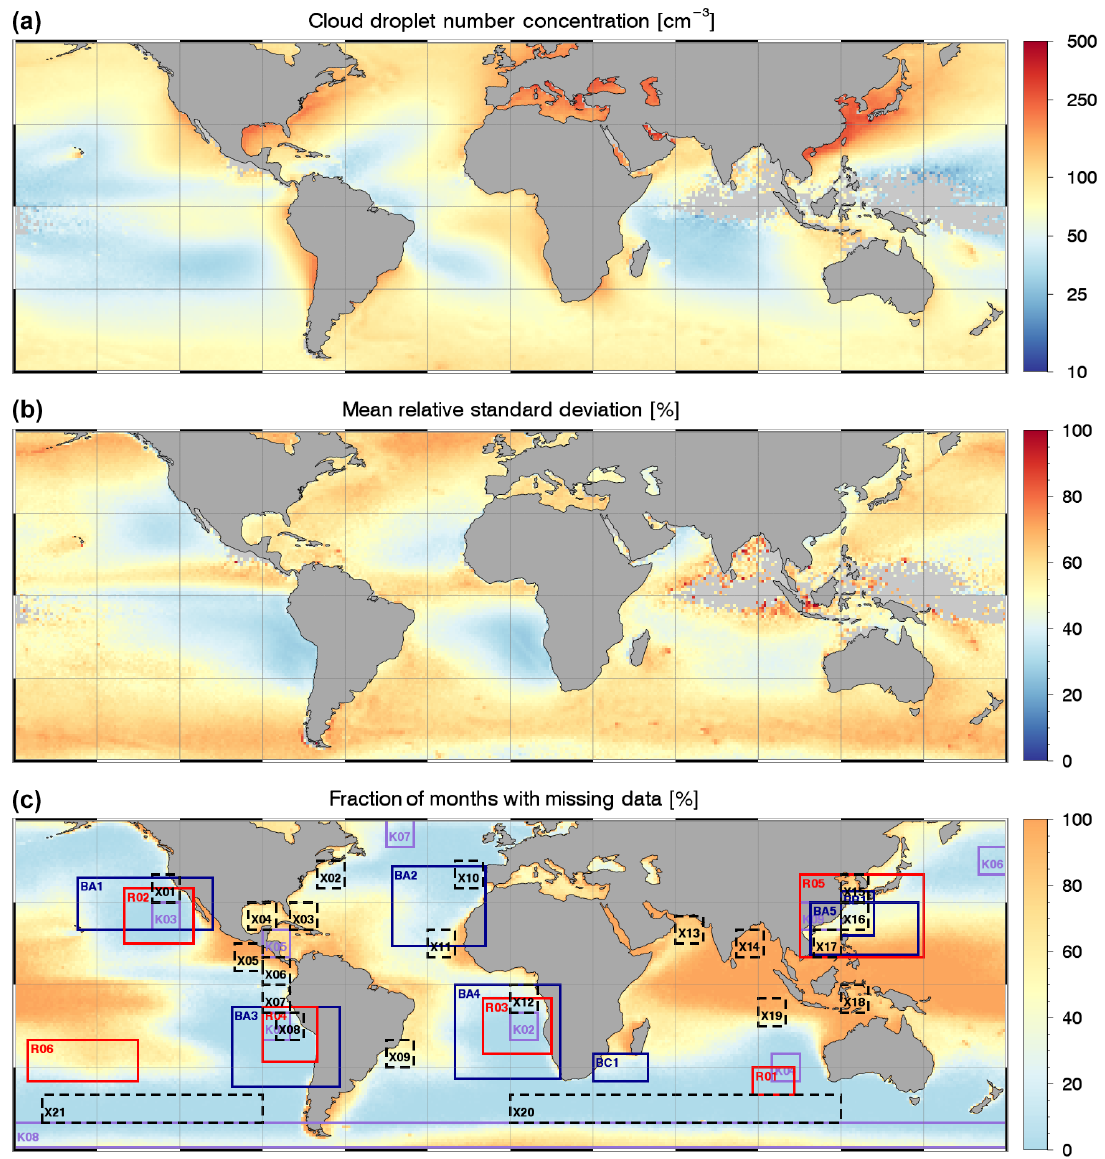
Figure 9. Panel (a) shows the mean CDNC over the period 2003–2013. Panel (b) shows the mean relative spatial standard deviation of the CDNC estimates and panel (c) shows the fraction of months with missing data in the climatology. Areas BA1–BA7 are defined in Bennartz (2007), BB1 in Bennartz et al. (2011), BC1 in this publication, K01–K09 in Klein and Hartmann (1993), R01–R06 in Rausch et al. (2010), and X01–X21 in Zhao et al. (2016). The corresponding latitude–longitude boundaries are also listed in Table